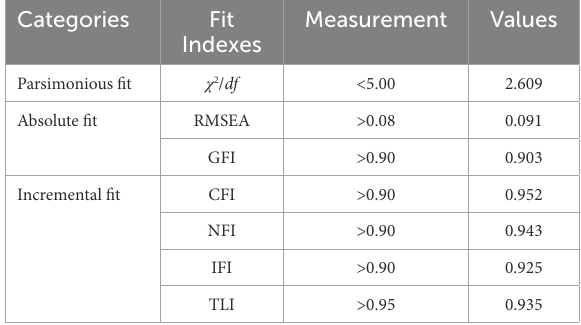
TABLE 4 Model fit indexes.